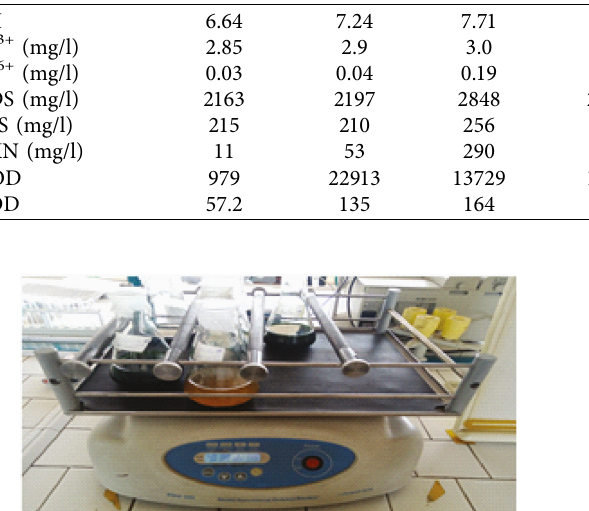
Physicochemical